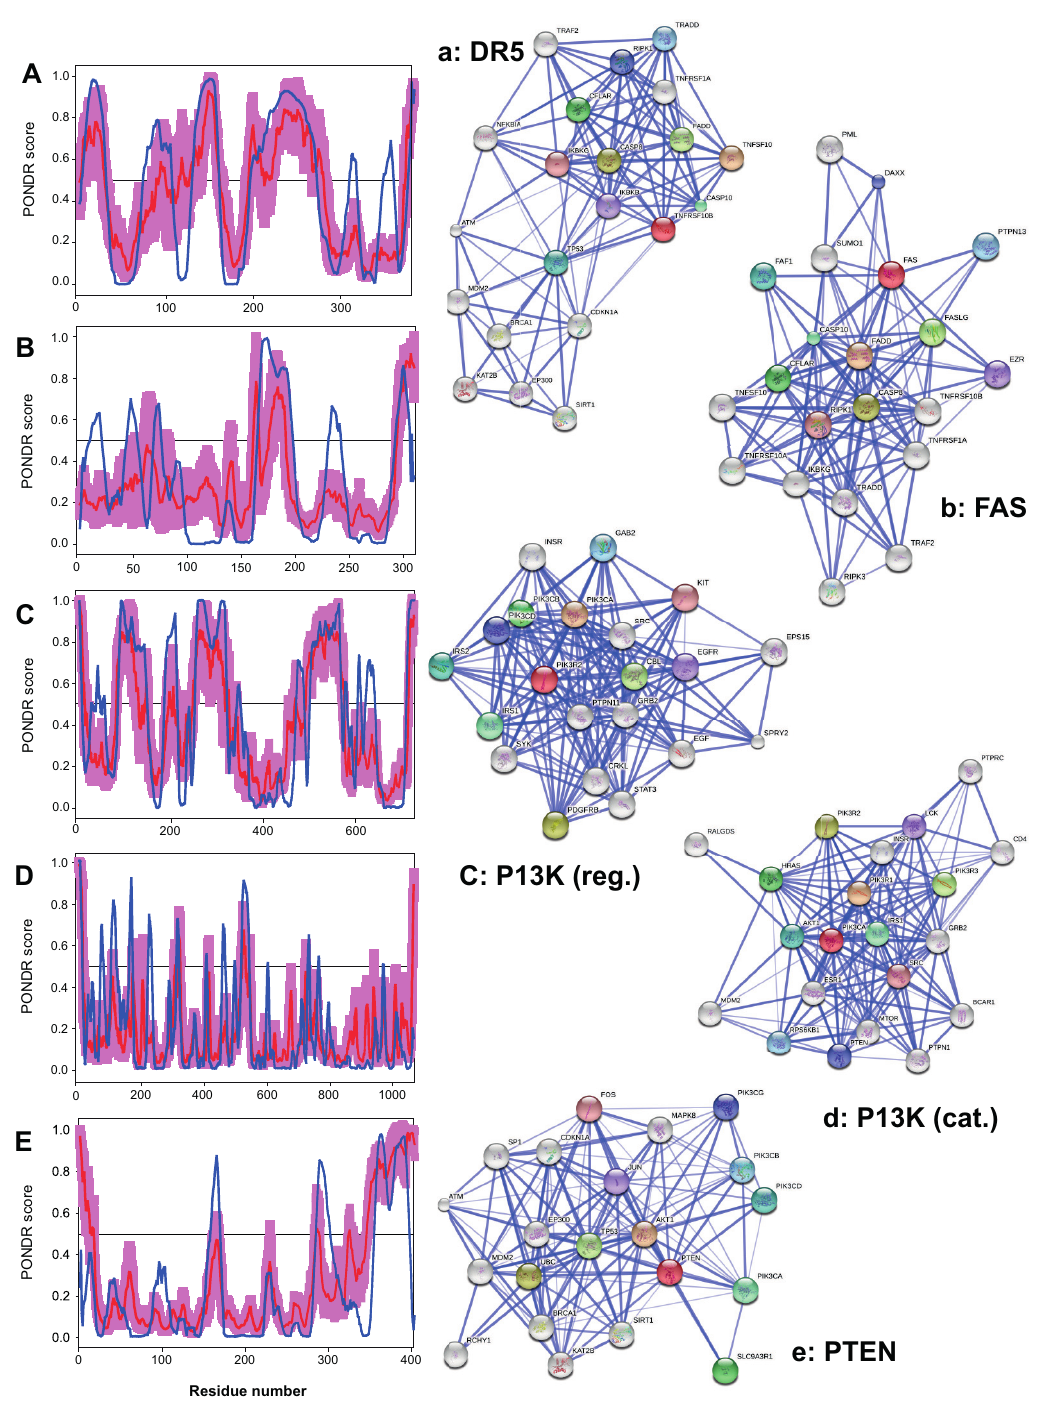
Figure 4. Intrinsic disorder (upper characters) of some human proteins involved in the p53-mediated apoptotic signaling pathways and STRING analysis (lower characters) of their interactomes: group II. A . and a . DR5 (UniProt ID: O14763); B . and b . FAS (UniProt ID: P25445); C . and c . PI3K regulatory subunit (UniProt ID: O00459); D . and d . PI3K catalytic subunit (UniProt ID: P42336); E . and e . PTEN (UniProt ID: P60484). Intrinsic disorder propensity was evaluated by PONDR-FIT (red curves and pink shadow) and PONDR ® VLXT (blue curves). The shadow around PONDR-FIT curves represents distribution of statistical errors. STRING database is the online database resource search tool for the Retrieval of Interacting Genes, which provides both experimental and predicted interaction information 92 . For each protein, STRING produces the network of predicted associations for a particular group of proteins. The network nodes are proteins. The edges represent the functional associations evaluated based on experiments, search of databases, and text mining. The thickness of edges is proportional to the confidence level 92